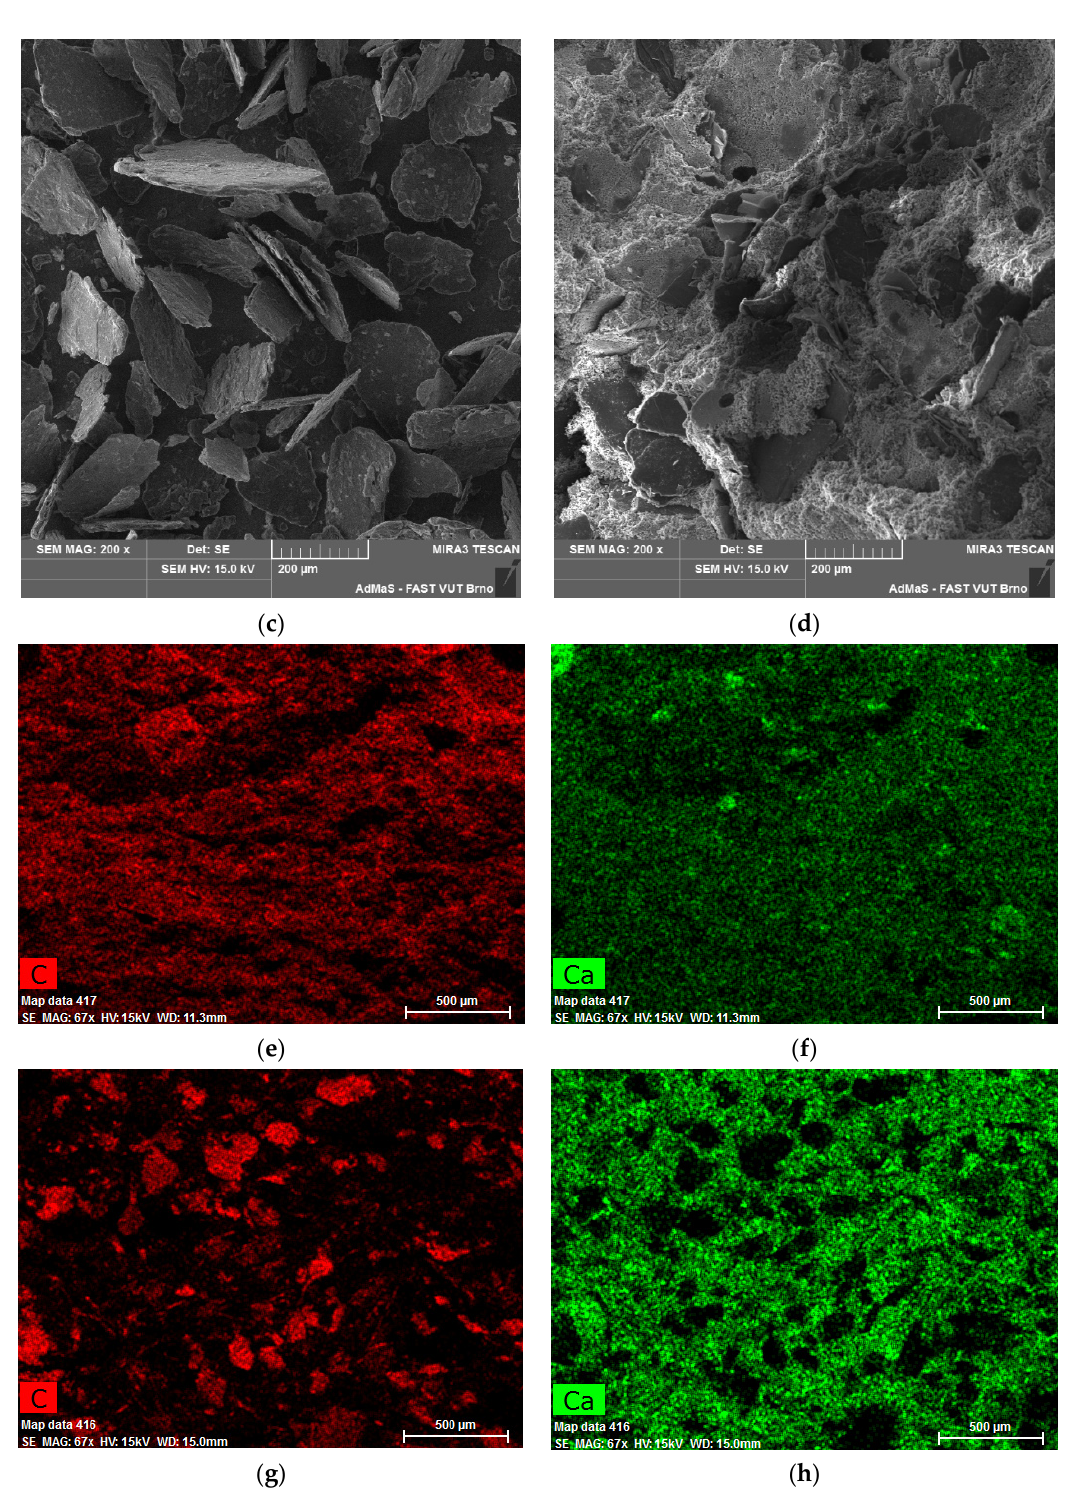
Figure 1. SEM images ( a ) Graphite A at 20k× magnification; ( b ) Graphite A in cement matrix at 20k× magnification; ( c ) Graphite B at 200× magnification; ( d ) Graphite B in cement matrix at 200× magnification; EDX method images; ( e ) Graphite A in cement matrix at 67× magnification, C—carbon detection mode; ( f ) Graphite A in cement matrix at 67× magnification, Ca—calcium detection mode; ( g ) Graphite B in cement matrix at 67× magnification, C—carbon detection mode; ( h ) Graphite B in cement matrix at 67× magnification, Ca—calcium detection mode.